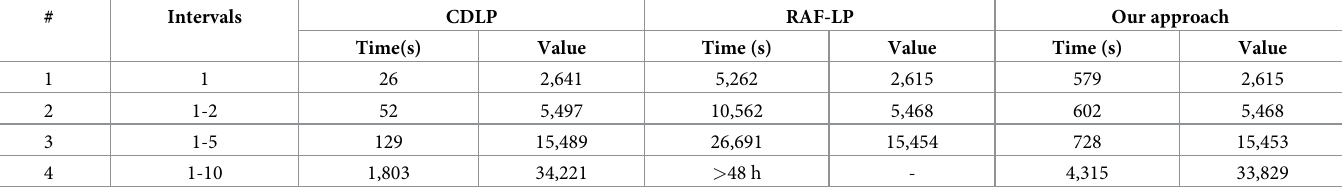
Table 8. Performance of our approach and two benchmarks.